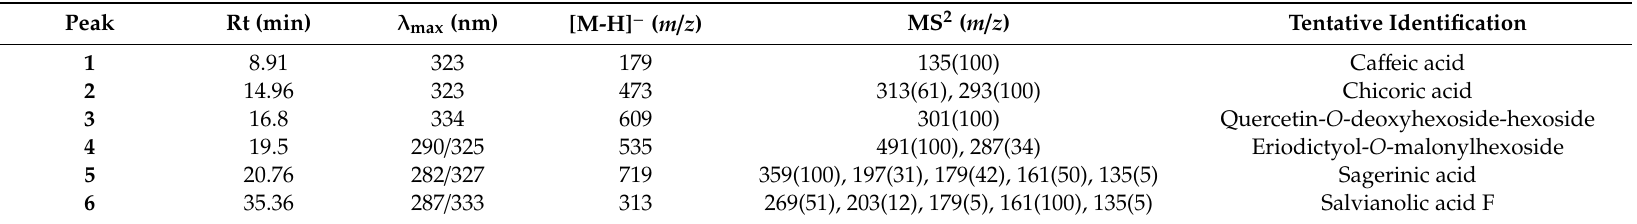
Table 4. Retention time (Rt), wavelengths of maximum absorption in the visible region ( λ max ), mass spectral data and tentative identification of the phenolic compounds present in the hydroethanolic extracts of basil leaves in relation to nitrogen